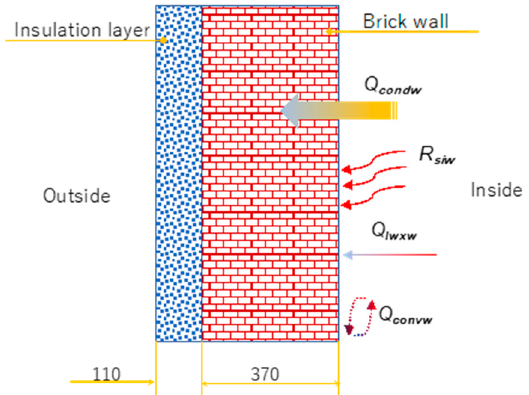
Figure 7. Heat transfers in the greenhouse wall (unit, mm).